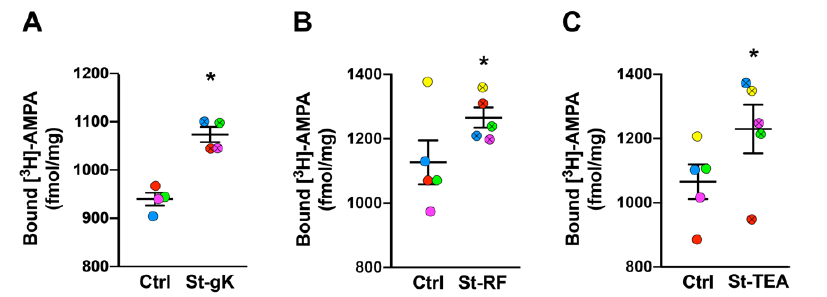
Figure 3. Long-term potentiation (LTP) is chemically induced in synaptosomes from superior frontal gyri of cognitively normal cases. All three chemical stimulation protocols, glycine-KCl (St-gK; A ), rolipram-forskolin (St-RF; B ) and TEA (St-TEA; C ), resulted in increased levels of surface AMPARs relative to their corresponding non-stimulation matched controls (Ctrl). Results are expressed as mean ( ± SEM) bound [ 3 H]-AMPA ( n = 4–5 for each experiment). * represents a statistical significance at p < 0.05. The respective stimulated and unstimulated synaptosome pairs are color coded in each